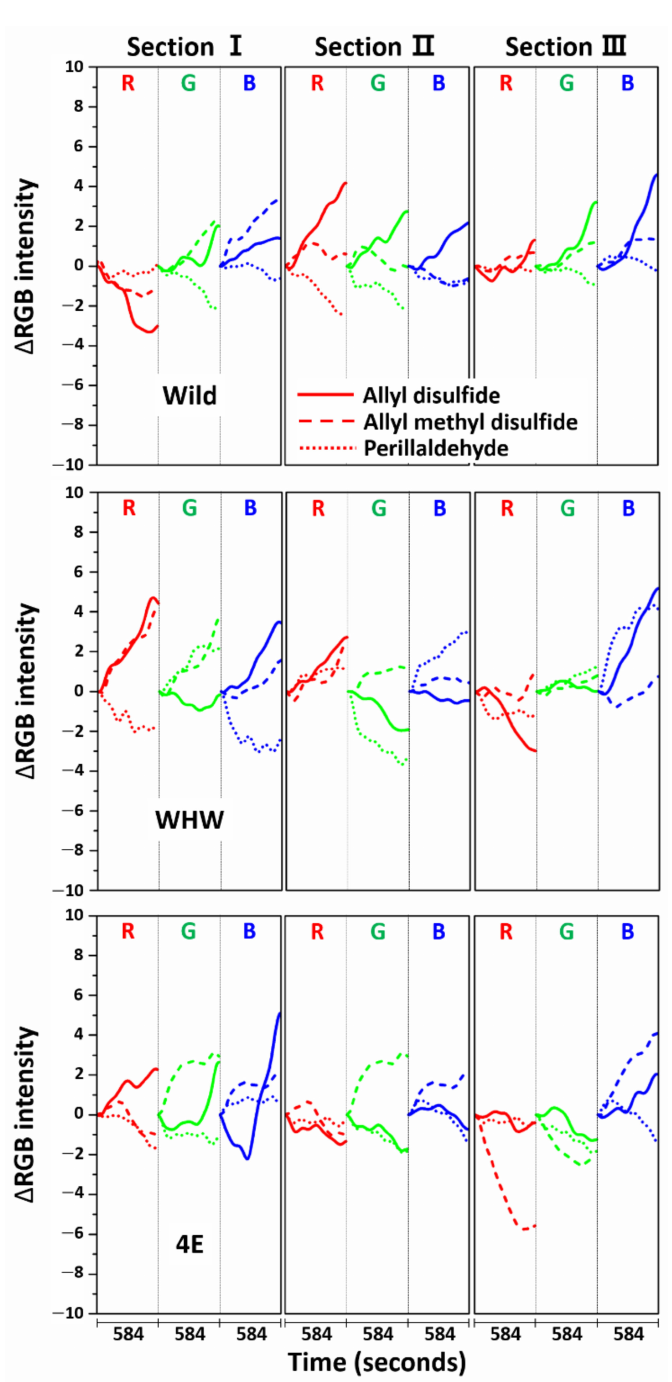
Figure 12. Average ∆ RGB intensity of allyl disulfide, allyl methyl disulfide, and perillaldehyde measured using Wild (top), WHW (bottom), and 4E sensors